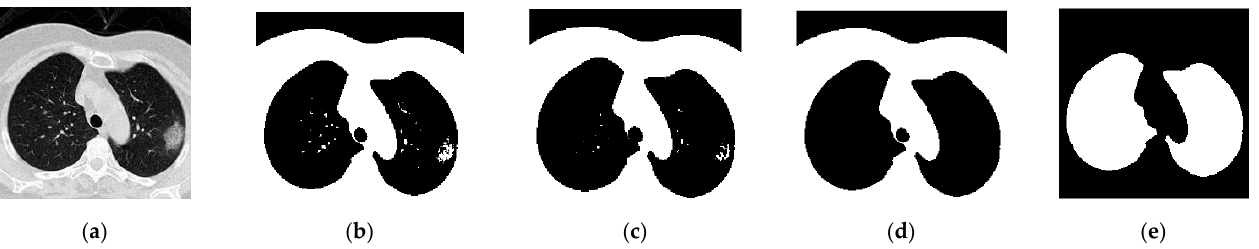
Figure 5. Sample significant output results during the process of using Erosion and Dilation-based technique to refine the mask for image lung regions: ( a ) Original Image. ( b ) Apply Maximum entropy threshold segmentation-based method to obtain the mask ( T 2 ). ( c ) Erode and dilate the mask ( T 3 ). ( d ) Remove unwanted connectivity areas of the mask. ( e ) Make an inversion of the values in the mask to achieve the final refined mask ( T 4